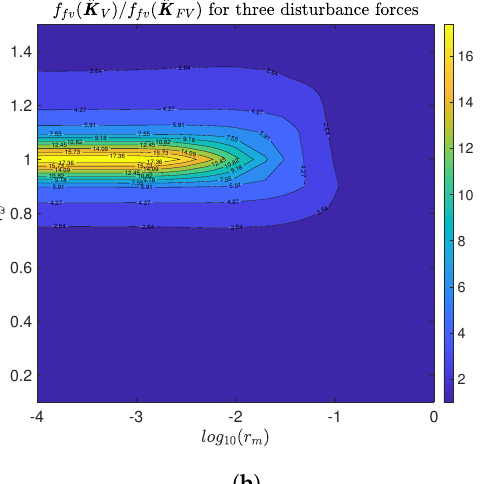
Figure 5. Ratio f fv ( ˆ K V ) / f fv ( ˆ K FV ) for: ( a ) a single disturbance force; and ( b ) three disturbance forces for the symmetrical case.